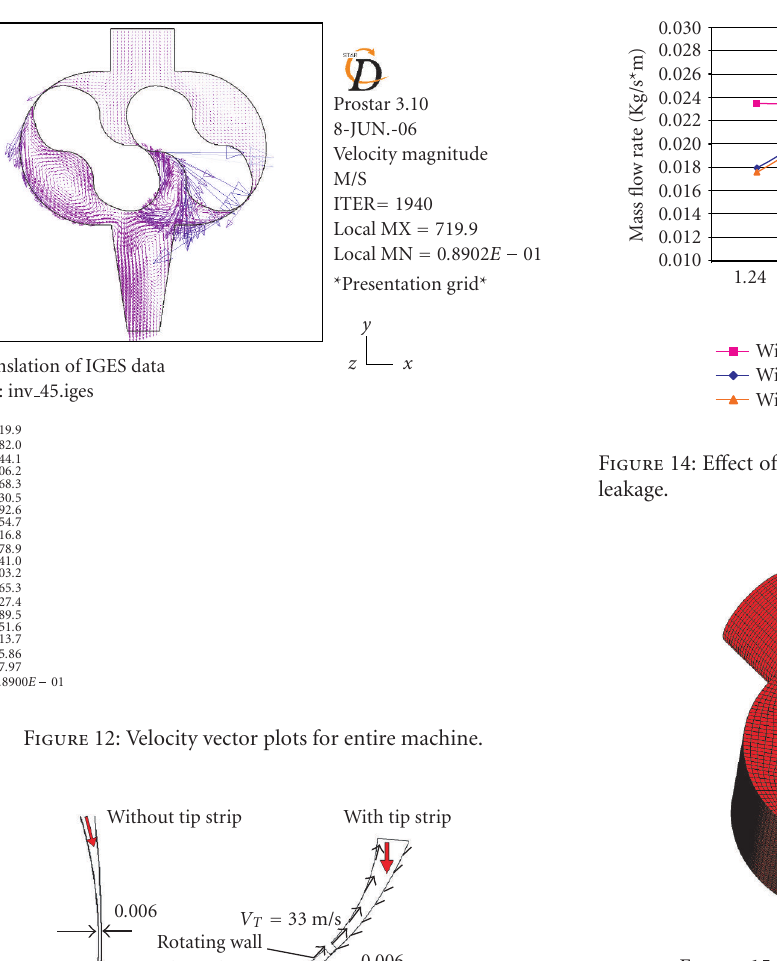
Figure 15: Mesh for 3D quasi-steady